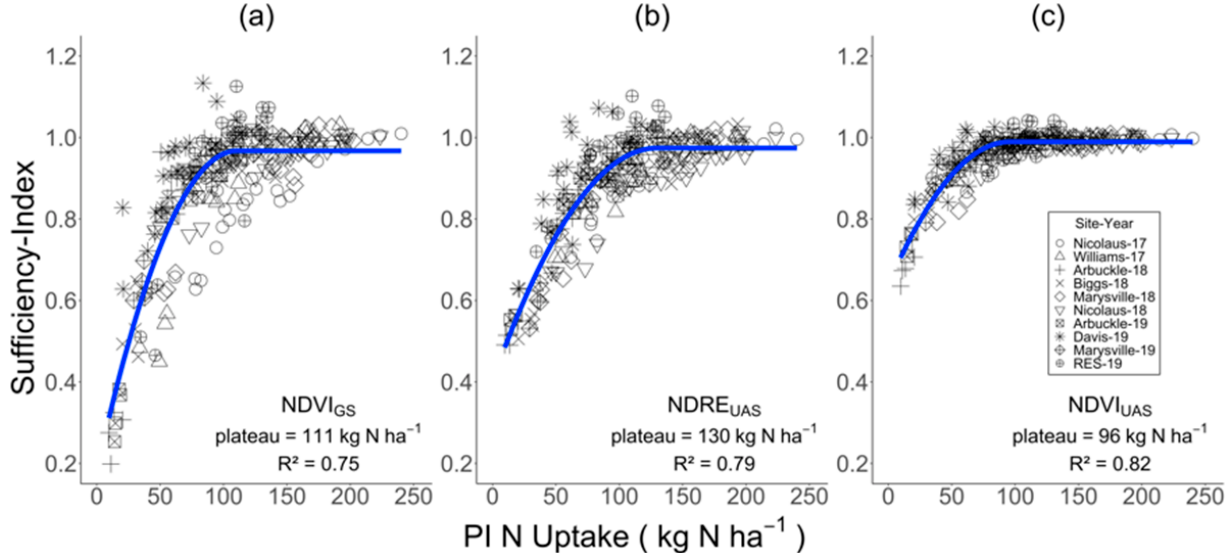
Figure 5. The relationship between panicle initiation N uptake (PI-N UP ) and ( a ) GreenSeeker (GS) Normalized Difference Vegetation Index (NDVI GS ) Sufficiency-Index (SI), ( b ) unmanned aircraft system (UAS) Normalized Difference Red-Edge Index (NDRE UAS ) SI, and ( c ) NDVI UAS SI as described by quadratic-plateau linear regression models. The plateau value reported in each panel represents the PI-N UP value where the regression model reached a plateau (i.e., the point of saturation for each index).